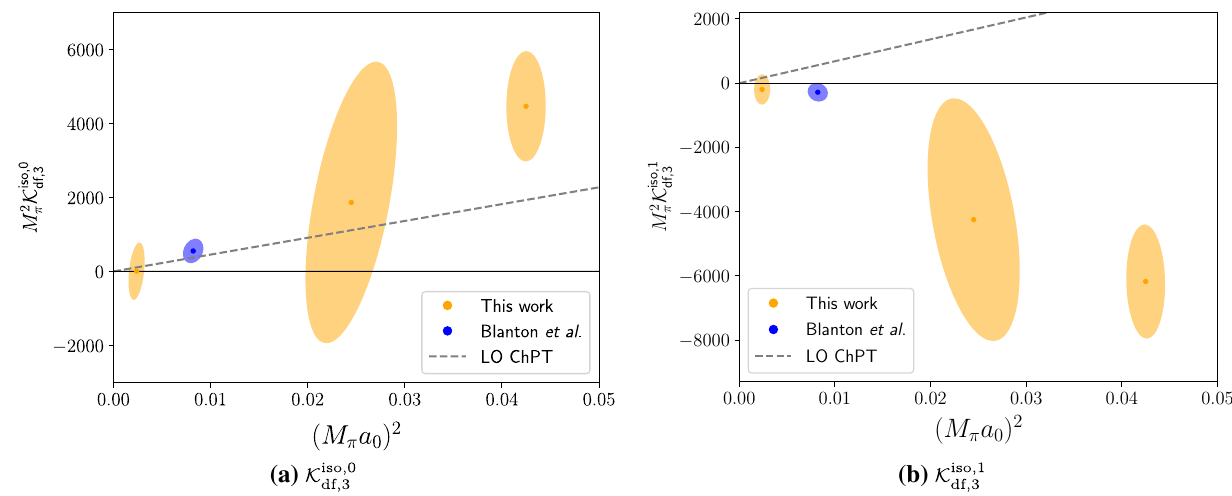
Fig. 3 Constant(left) and linear(right) terms of K 3,df as a function of the s -wave scattering length. We also include the results of Ref. [69]